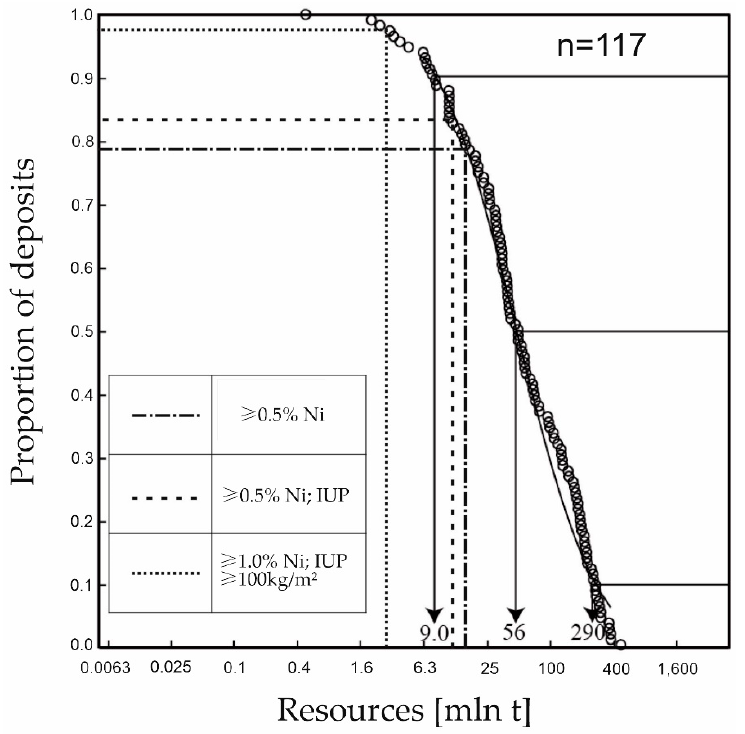
Figure 14. Compilation of Ni laterite ore resources data for 117 global deposits with plotted resource estimation results for Block B of the Central Halmahera deposit for several selected cut-off criteria. On the basis of [4] modified. Intercepts for the 90th, 50th, and 10th percentiles of the observed distribution are provided.